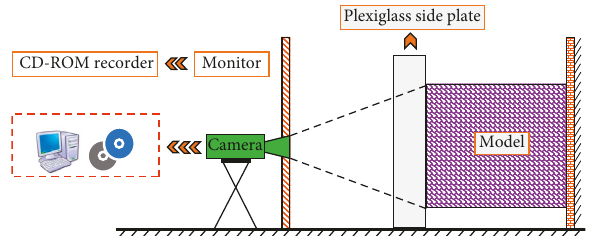
Figure 3: Monitoring system.